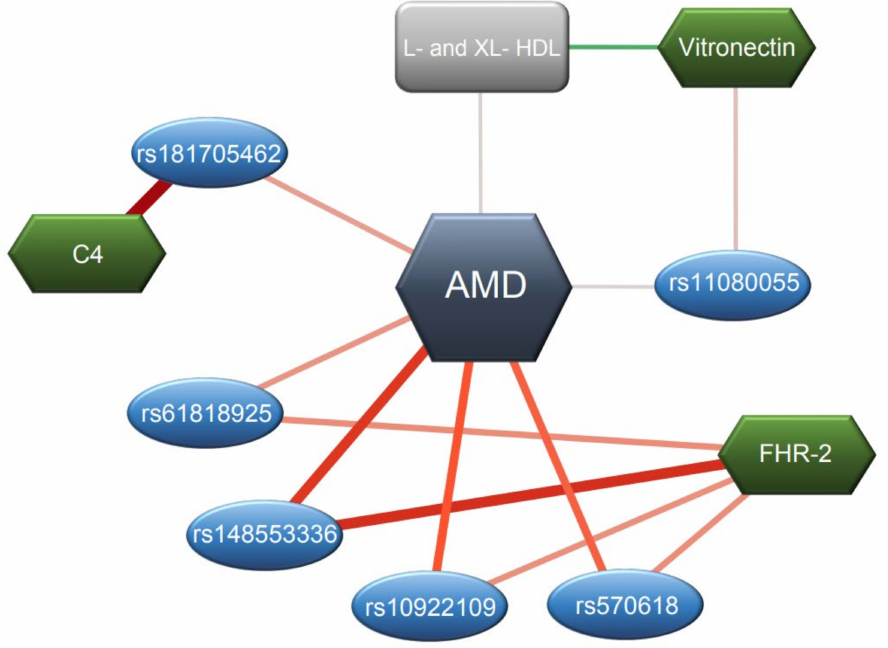
Figure 6. Schematic overview of associations of complement proteins with genetic variants and metabolites. AMD is highlighted in the center in red, complement proteins are highlighted in blue diamonds, genetic variants are highlighted in purple circles and metabolites are highlighted in yellow squares. Only the significantly associated proteins, genetic variants and metabolites are shown. Green colored connections show associations with beta estimates smaller than zero, which indicate associations with lower levels. Red colored connections show associations with beta estimates larger than zero, which generally indicate associations with higher levels. The color of the line is closer to gray as the beta estimate gets closer to zero. Association lines are represented thicker for the higher absolute beta estimates, and thinner for the lower absolute beta